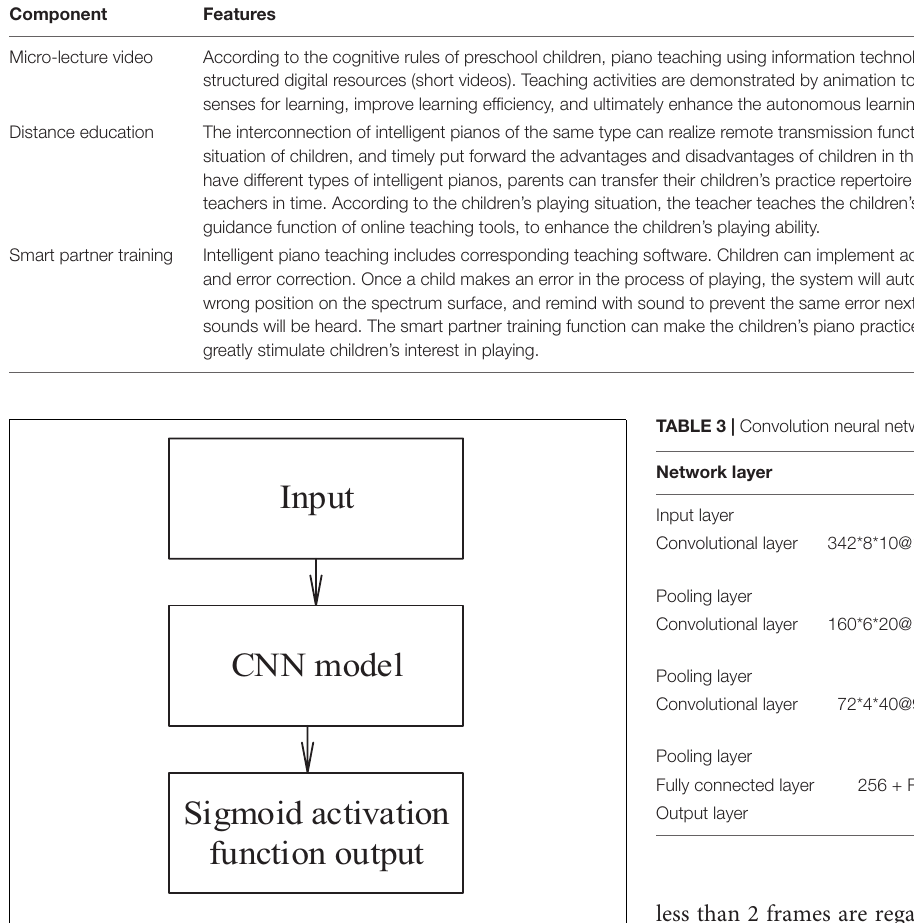
FIGURE 3 | Piano music onset detection based on deep learning (DL).